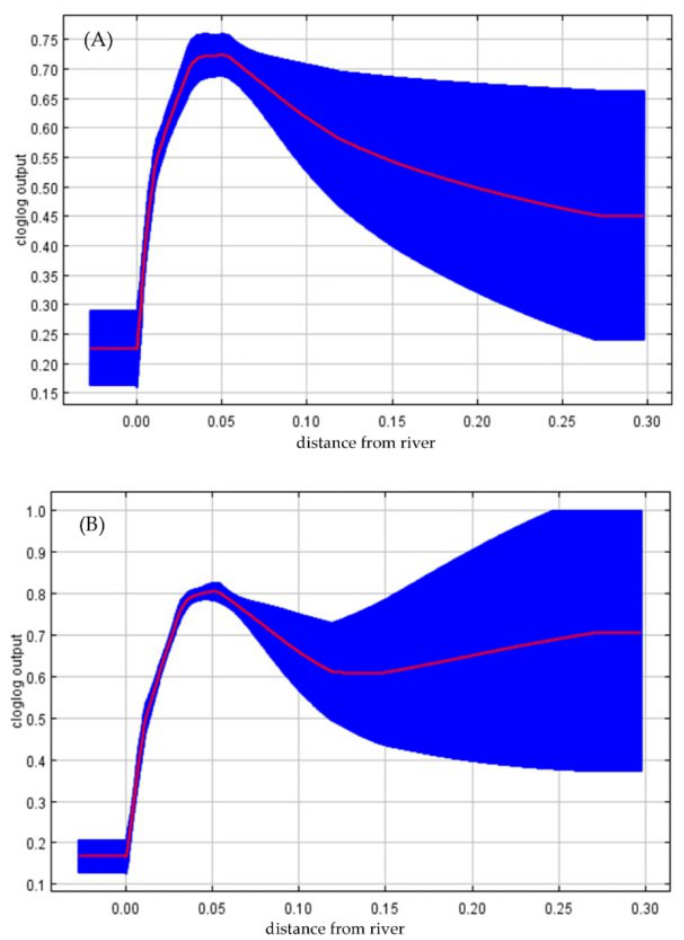
Figure 4. The response curve for the variable distance from the river ( A ) with other variables; ( B ) without other variables.